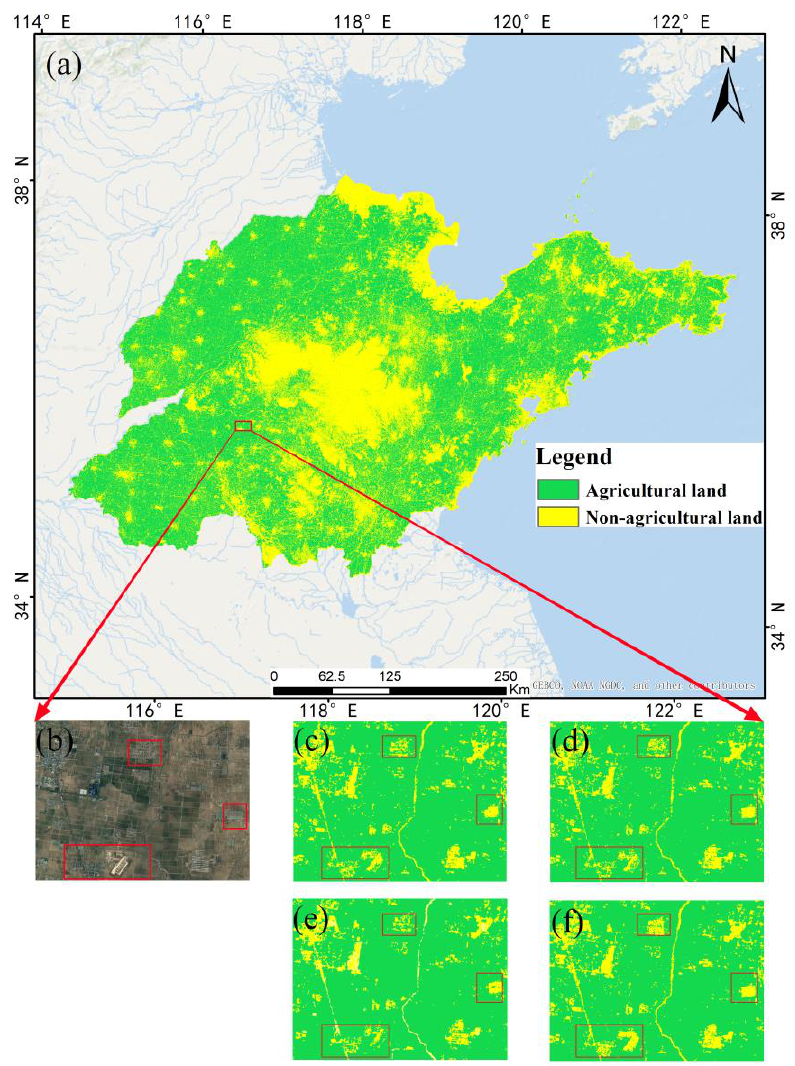
Figure 7. Comparison of different classification methods. In the results, we marked the obvious differences between each classification method with red boxes. ( a ) Winter wheat distribution map in Shandong Province; ( b ) optical image; ( c ) results of random forest classification; ( d ) results of gradient lifting tree classification; ( e ) results of decision tree classification; ( f ) results of ensemble learning classification.